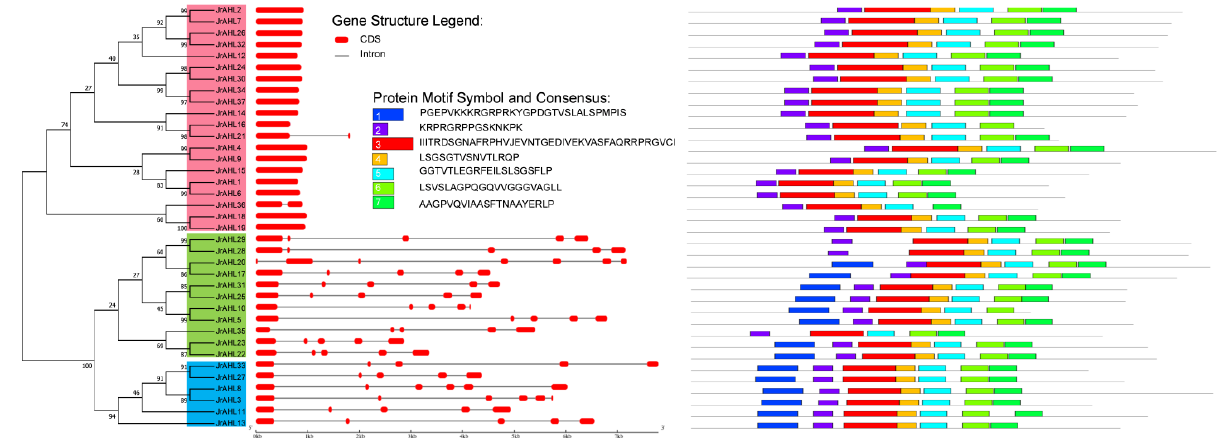
Figure 3. Gene structure analysis and conservative motif prediction of the AT-hook motif gene family in walnut. The gene structure map was obtained with the GSDS online tool ( left ). The x -axis shows the inferred length of the different genes (5′ to 3′) and their respective CDS (red). Domain structure and motif were elucidated with the MEME platform ( right ).